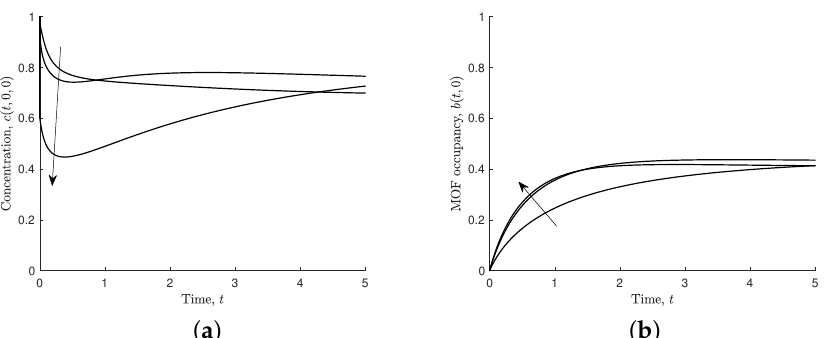
Figure 11. Results for different values of non-dimensional diffusion, s 1 = 0.1,1,5, s 2 = s 3 = s 4 = 1, and D = 0.5. Arrows indicate the direction of increasing s 1 . ( a ) Non-dimensional concentration of ferric ions through MOF mid-point across two media, c ( t ,0,0 ) . ( b ) Non-dimensional MOF occupancy, b ( t ,0 ) .